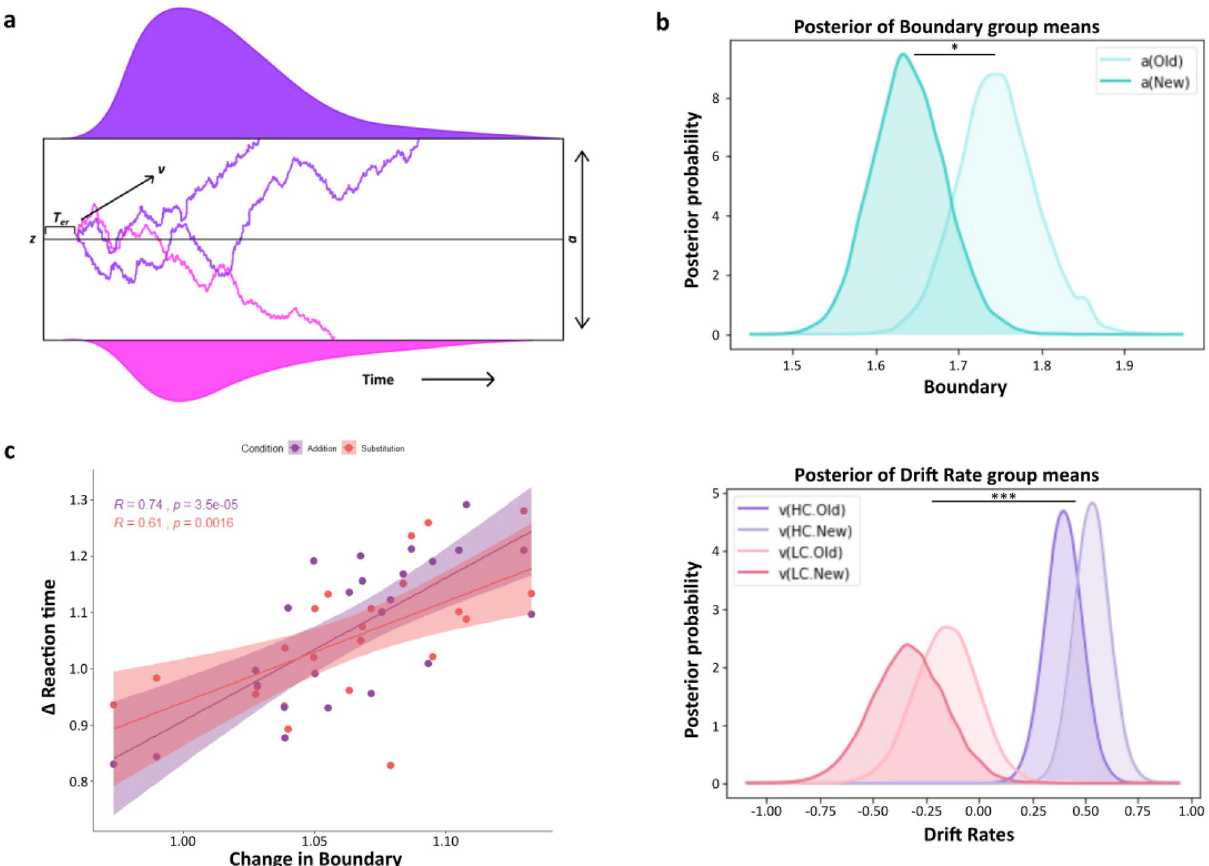
Figure 6. Hierarchical DDM results. ( a ) An illustration of the DDM. The drift rate v reflects the rate of noisy accumulation of evidence until it reaches either of the two boundaries separated by a parameter a . The process starts at point z, which may or may not have a response bias (not included in the main model) towards either boundary, which results in the model making the response choices. The response times are a combination of the diffusion process and the non-decision time T er , which includes no accumulation. Recalling sequences would reinstate the original encoded memories from which a decision is made. Response times for the temporal order judgements can be due to an increased drift rate or decreased boundary threshold. ( b ) Posterior density plots of the group means boundary parameter (top) showing higher evidence requirement for the Old sequences compared to New ( p = 0.026). Posterior density plots of the group mean drift-rate parameter (bottom) showing no difference between the Old and New sequences but only between High and Low confidence responses ( p < 0.001). ( c ) Subsequent adjustment in decision criteria made by the participants (boundary parameter) for recalling newer memories (compared to old ones) were significantly correlated with their relative change in reaction times in Addition (Purple) r = 0.74, p < .001 and Substitution (Pink) r = 0.61, p = .0016. Dots represent individual